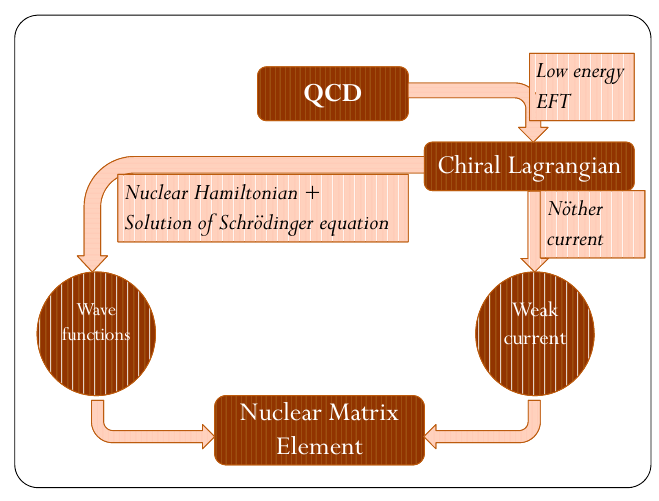
Fig. 1. A block diagram of the approach suggested by χ PT to calculate weak